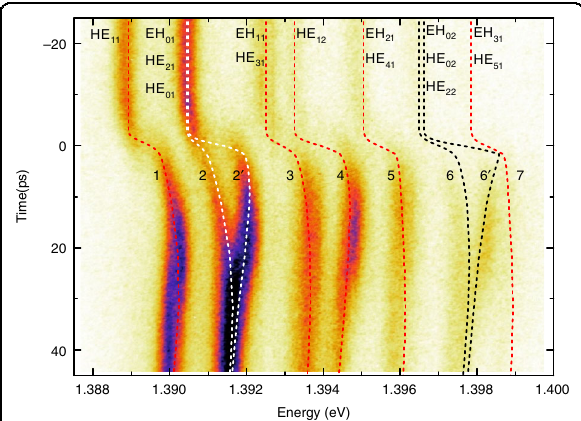
Fig. 3 Mode splittings induced by a focused off-axis pump beam. The streak camera image is obtained for a 5.3 μ m diameter QDM. Here, E p = 1.55 eV and P = 10 pJ/pulse. The Gaussian pump beam has a 1.1 μ m diameter at waist and is focused 0.9 μ m away from the center of the QDM top facet. The dashed lines correspond to the calculated mode frequencies 48 (for this simulation, the maximum refractive index change Δ n = − 0.06). The splitting of Lines 2 and 6 due to the breaking of the circular symmetry of the QDM through asymmetric carrier injection is highlighted by this